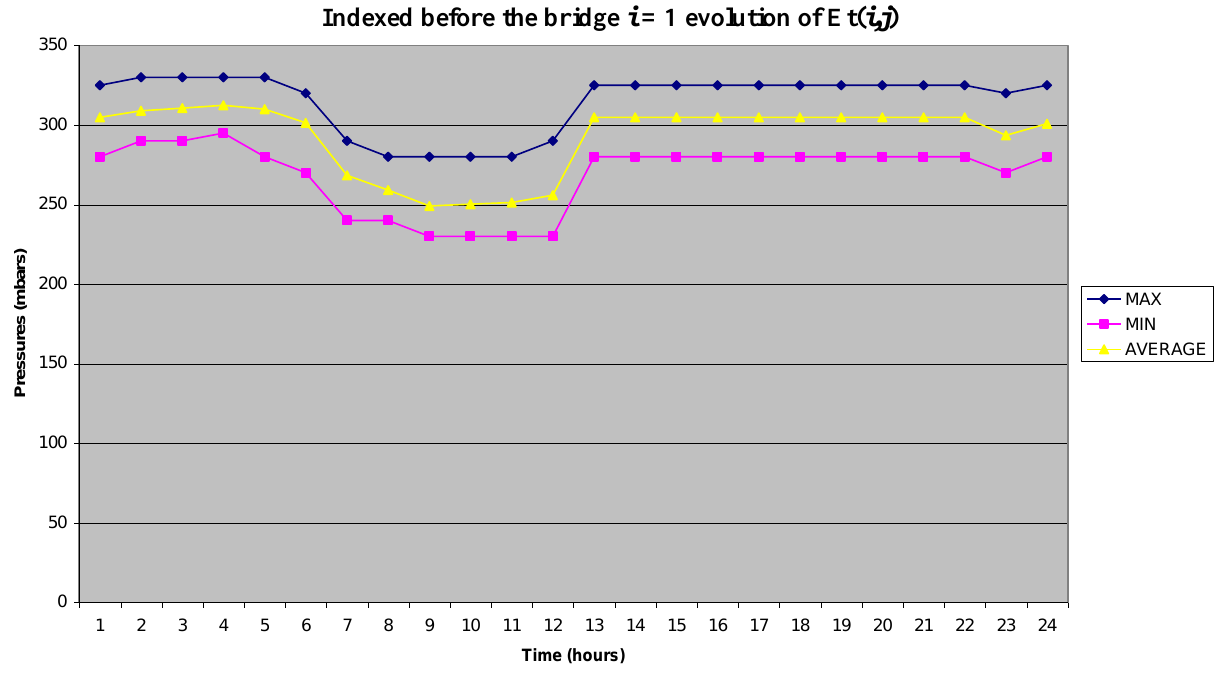
Figure 5. Curve of the pressures before the bridge. INDEXED THE BRIGE Indexed before the bridge i = 1 evolution of Et( i,j )